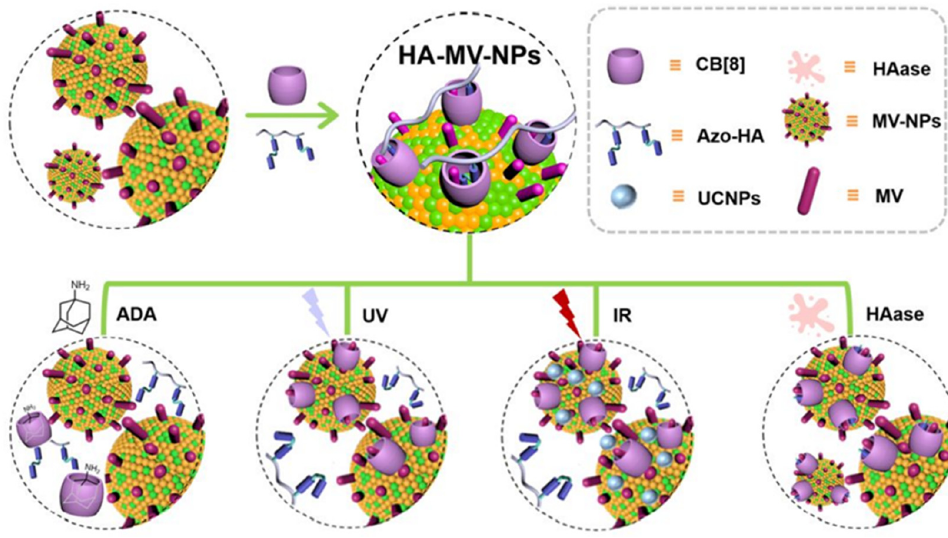
Figure 23. Schematic diagram of preparation and application of HA-MV-NPs (reproduced with permission of American Chemical Society from ref. [99]).